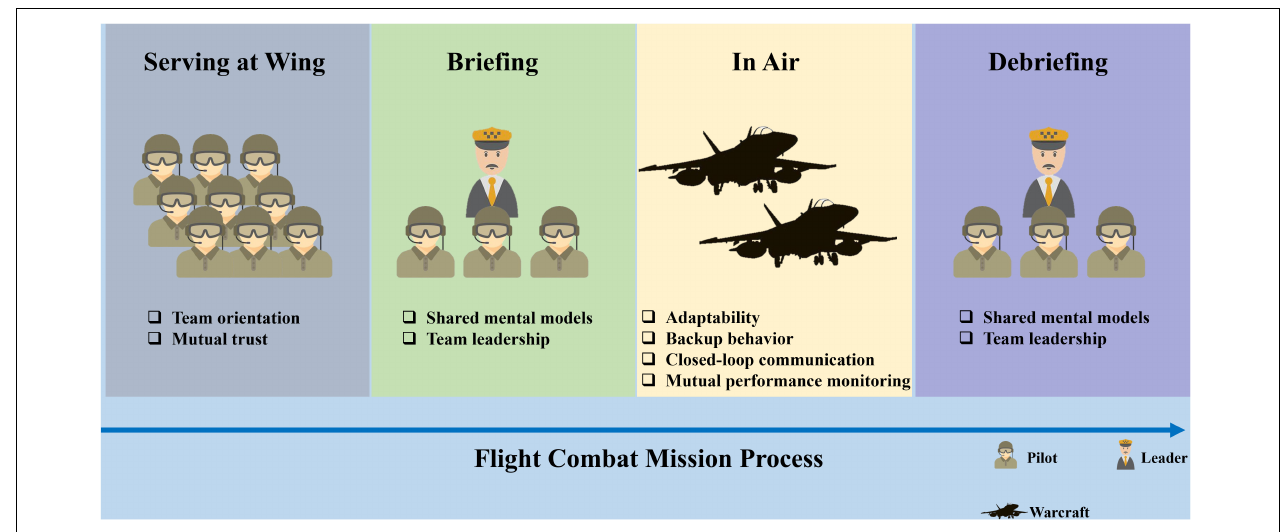
FIGURE 1 | Teamwork factors required at different flight combat mission stages. Adapted from Ohlander et al. (2019).